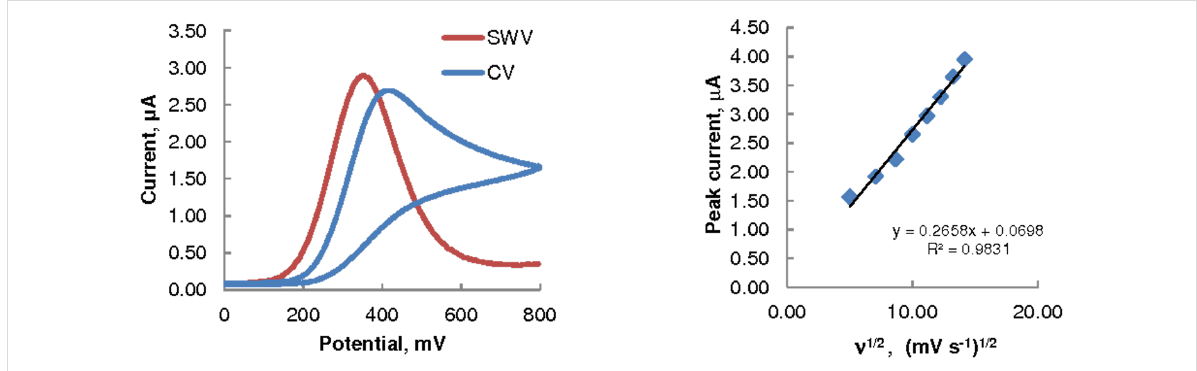
Figure 1: Typical CV and SWV voltammograms (left) at a bare GCE, 2 mmol/L AA in 0.1 M acetate buffer (pH 3.7), scan rate = 75 mV/s; depend- ence of CV peak currents on the scan rate ν